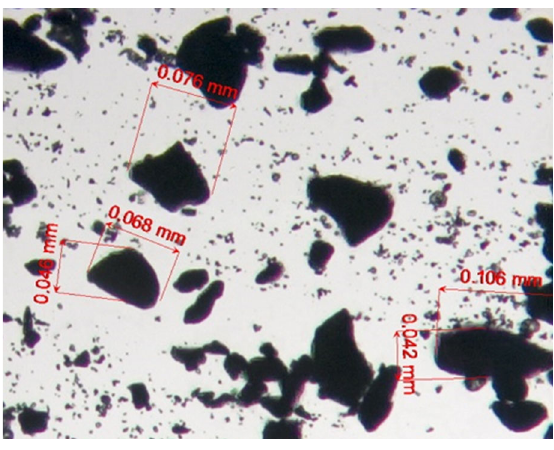
FIG. 5. Powder size distribution percentage [% V=V ].